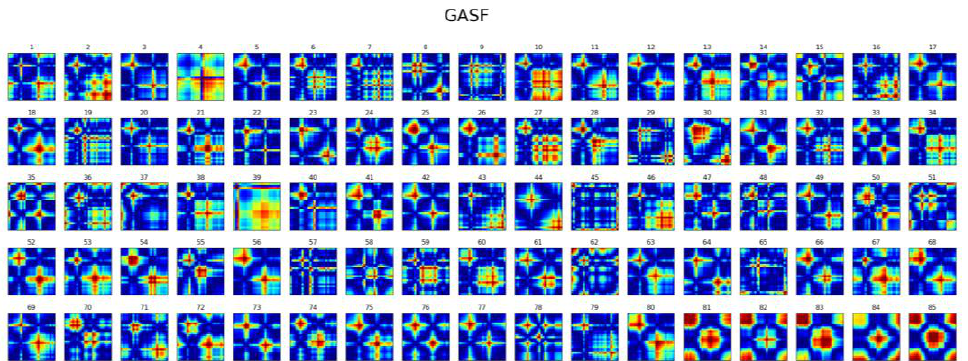
Figure 11. Time series image datasets recorded for 85 days (GASF).